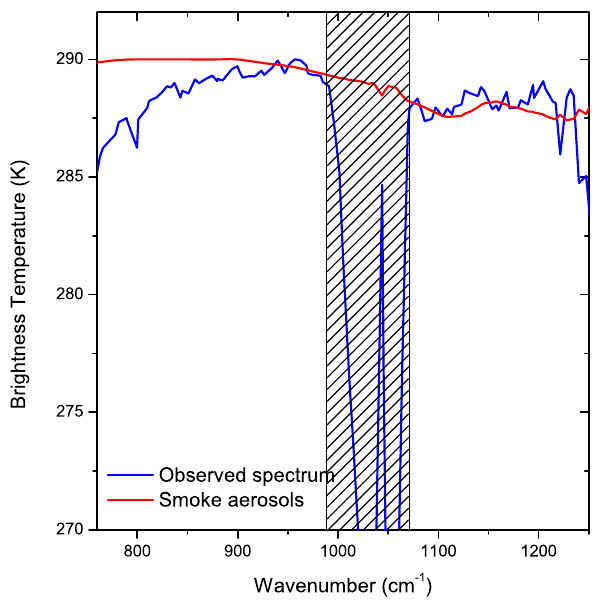
Fig. 11. Smoke aerosol signatures in observed and simulated spec- tra. The blue spectrum was observed over the Indian Ocean in Oc- tober 2010. The red spectrum is a simulated spectrum using refrac- tive indices of smoke from a mixed weed sample (Sutherland and Khanna, 1991).